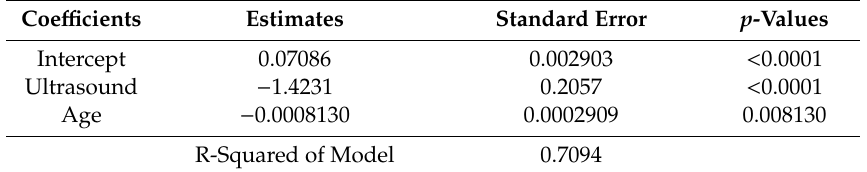
Table 2. Linear regression: chest fluoroscopy measurements vs. ultrasound